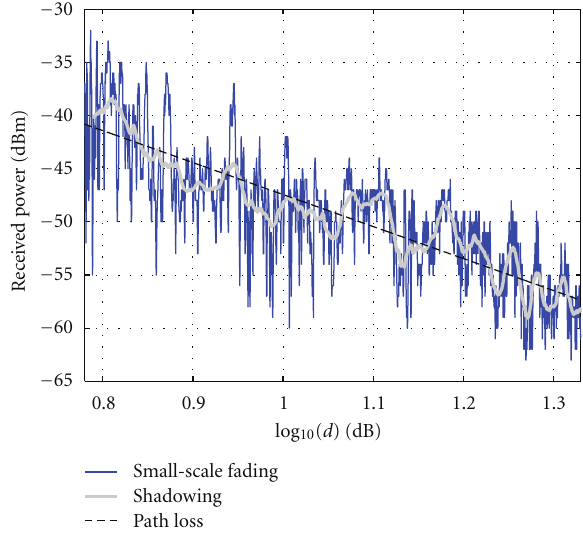
Figure 6: Underlying dynamics of the received signal power across route 1 of Figure 5 and for the transmitter at location #1. The blue curve is the measured received power which exhibits small- scale fading. By averaging locally over small-scale variations, the underlying shadowing variations can be seen (gray). The average of the shadowing variations then follows the distance-dependent path loss curve (dashed